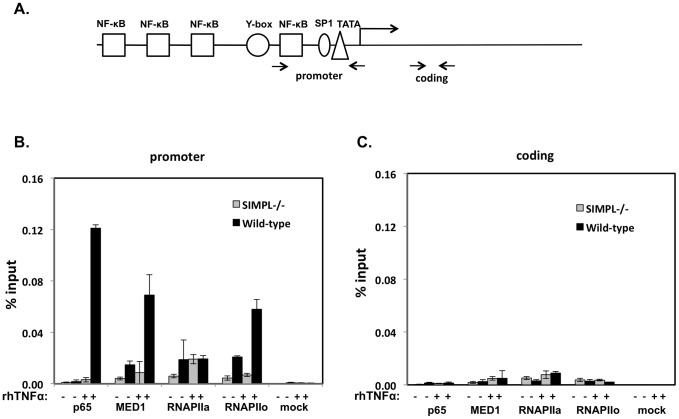
SIMPL enhances the appearance of p65, MED1 and serine 5 phosphorylated RNA pol II on the Tnf gene promoter.(A) Schematic of the mouse Tnf gene indicating location of PCR primers. (B and C) MEFs derived from littermate controls (WT) or SIMPL−/− mice were left untreated (-) or were treated with rhTNFα (10 ng/ml) for 45 minutes. Chromatin immunoprecipitation (ChIP) assays were performed as described under Materials and Methods with the indicated antibodies and primer sets specific for the mouse Tnf gene (see Panel A for location of primers; Materials and Methods for sequence of primers). ChIP assays were repeated at least three times.